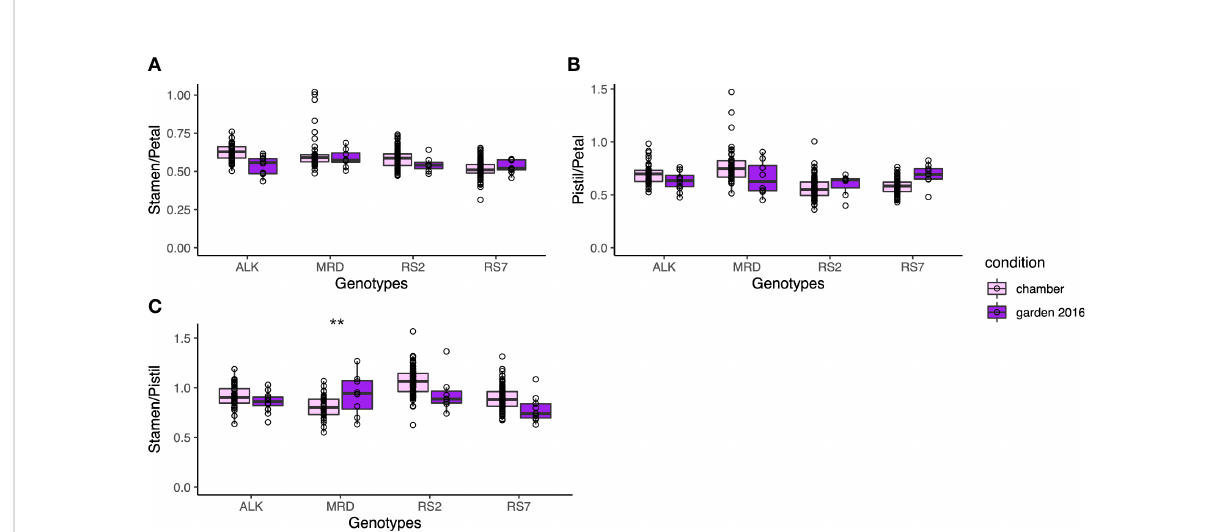
FIGURE 5 The traits representing the relative position of each organ. (A) Ratio of stamen length and petal length. (B) Ratio of pistil length and petal length. (C) Ratio of stamen length and pistil length. The asterisk represents the P-value by Levene test (*: P<0.05; **: P<0.01; ***: